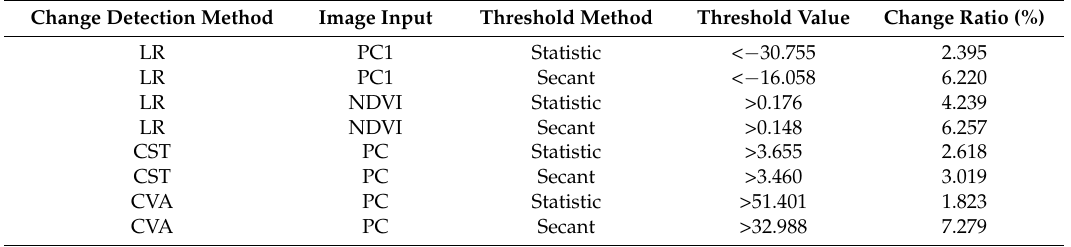
Table 2. Change ratio resulting from the landslide detection.